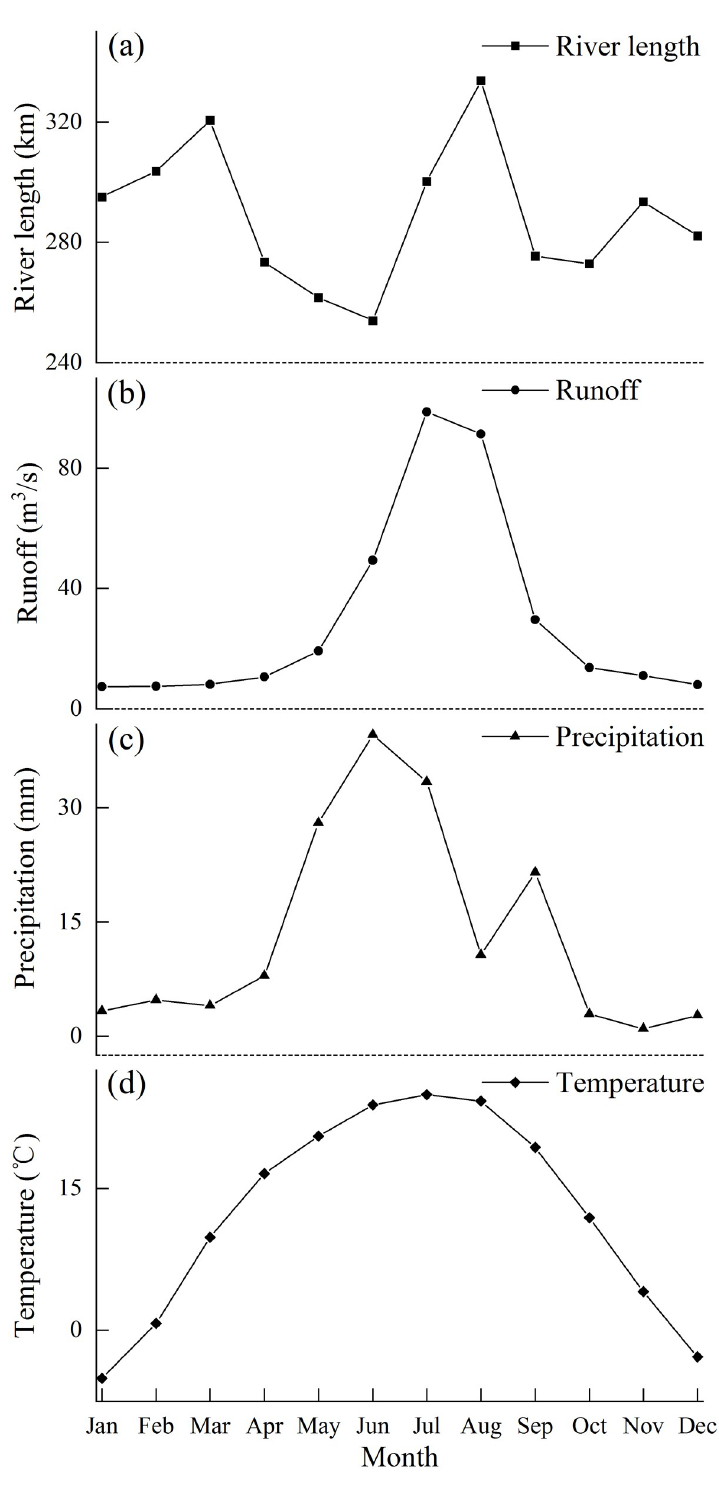
Fig 10. Observed intra-annual changes between lower reach river length and natural upper reach factors in the Keriya River Basin. (a), (b), (c) and (d) represent the seasonal changes in lower reach river length, upper reach runoff, precipitation and temperature,